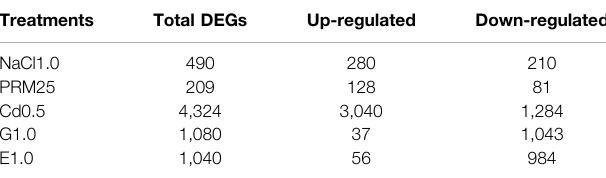
TABLE 1 | Differentially expressed genes (DEGs) based on RNA-seq under different treatments compared with the control. Treatments include supplementation with paromomycin (PRM25, 25 μ g/ml), ethanol (E1.0, 1.0% vol/ vol), glucose (G1.0, 1.0% weight), CdCl 2 (Cd0.5, 0.5 mM), or NaCl1.0 (NaCl as 1.0%